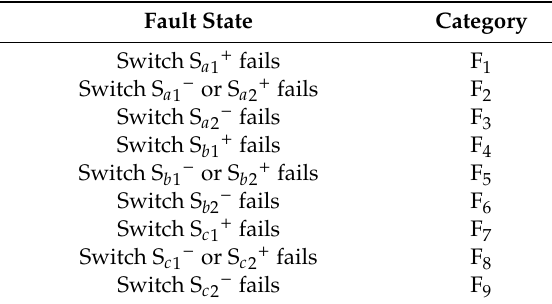
Table 1. Power transistor fault categories.